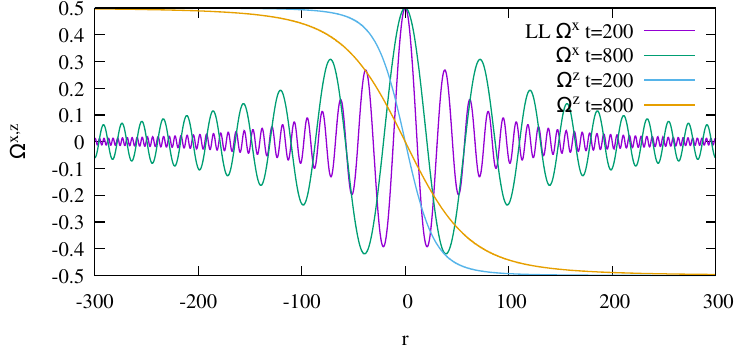
Figure 1: Ω x and Ω z magnetization profiles for the isotropic LL model ( ∆ = 1) at t = 200 and t = 800 (initial condition given in Eq.